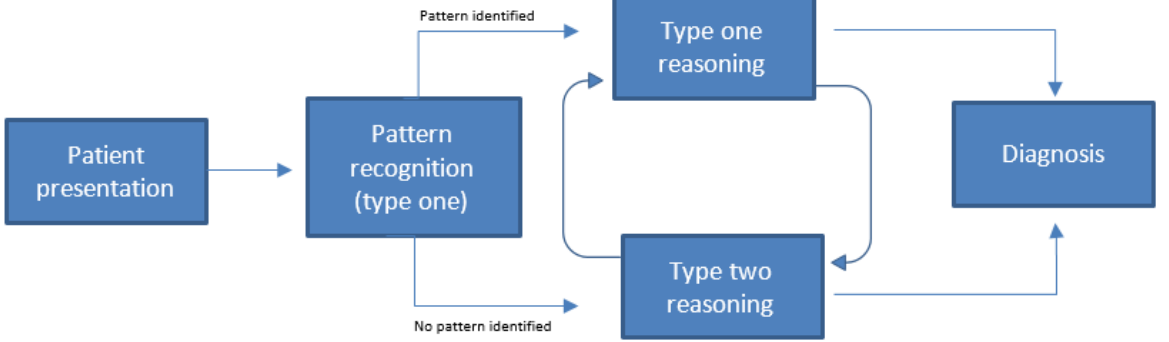
Figure 1 . Dual-process reasoning. The dual-process model of clinical reasoning in a diagnostic situation, adapted from Croskerry